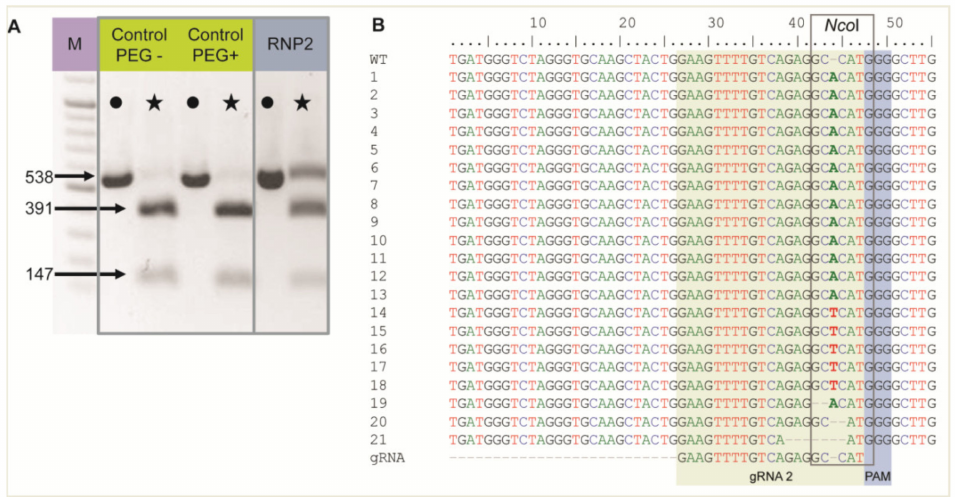
Figure 1. The carrot F3H gene fragment edited after delivery of RNP2 to PEG-treated protoplasts. ( A ) DNA of control and RNP2-treated protoplasts. Lanes with the PCR amplified WT 538 bp fragment are marked by dots while lanes with products after incubation with Nco I endonuclease recognizing the restriction site at the gRNA2 target site are marked by stars. ( B ) Independent mutant variants of the F3H gene aligned to WT and gRNA2 sequences with the Nco I restriction sitemarked. M—GeneRuler DNA Ladder Mix (Thermo Fisher Scientific, Waltham, MA,